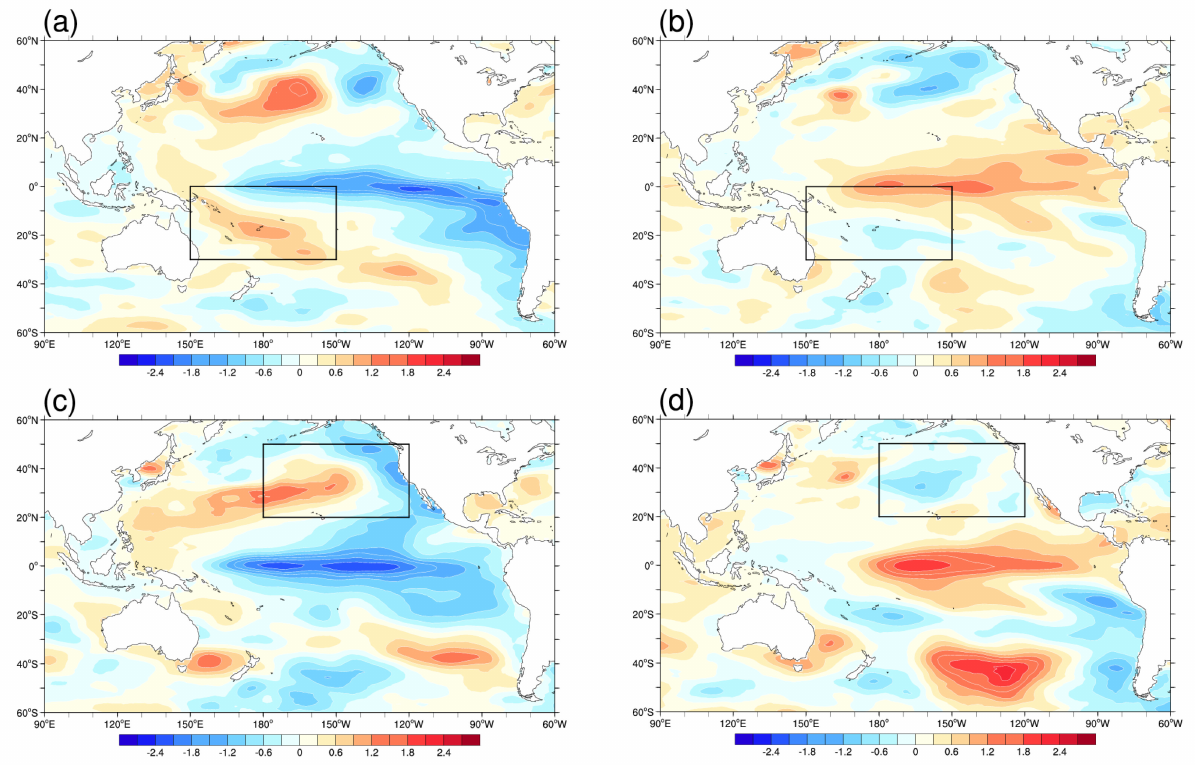
Figure 10. The seasonal sea surface temperature anomaly for ( a ) 2007 autumn; ( b ) 2009 autumn; ( c ) 2007–2008 winter; and ( d ) 2009–2010 winter over the